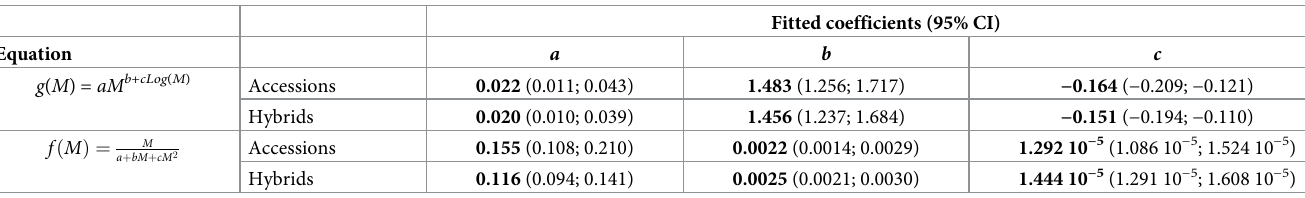
Table 1. Coefficients of fitted allometric